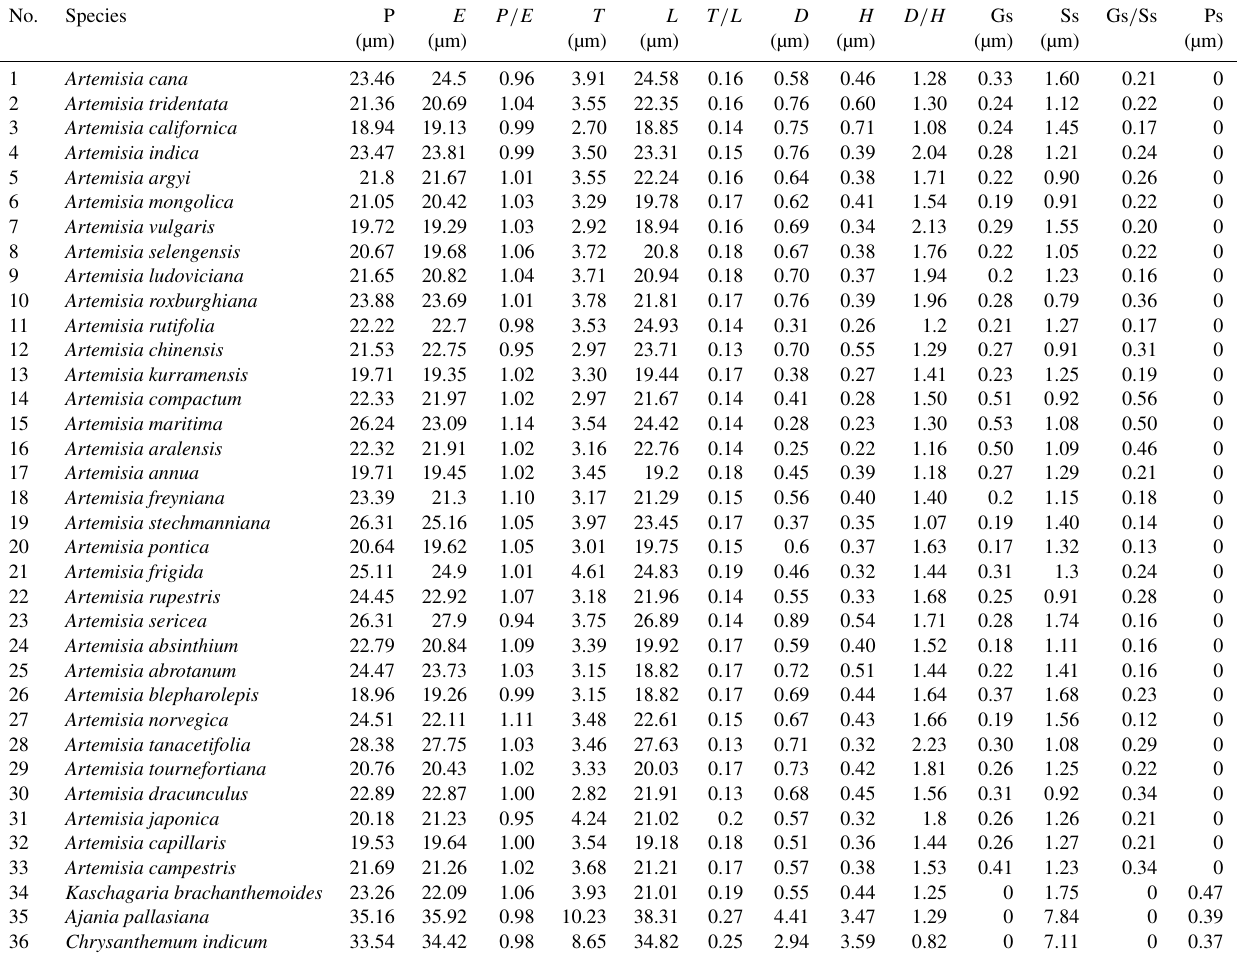
Table 1. Pollen morphological traits of 36 selected species (P: polar length; E : equatorial width; T : exine thickness; L : pollen length; D : diameter of spinule base; H : spinule height; Gs: granule spacing; Ss: spinule spacing; Ps: perforation spacing). No.